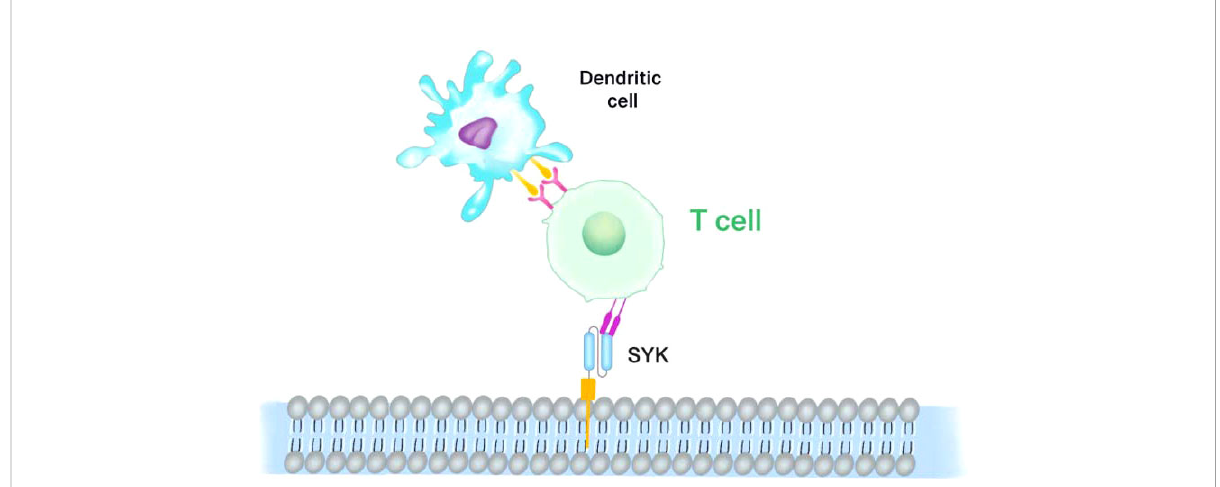
FIGURE 5 SYK-targeted dendritic cell-mediated CAR-T cells. Dendritic cells (DCs) which expressing and presenting the SYK peptide antigen are modi fi ed to cytotoxic T lymphocytes (CTL). SYK-overexpressing DCs induce the cytotoxicity of